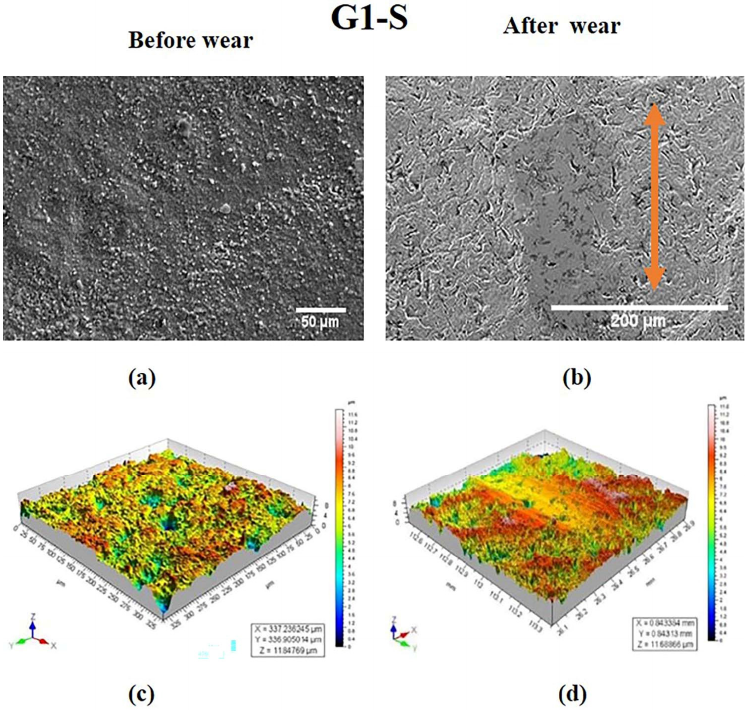
Figure 2. SEM images of specimen in G1 group at magnifications of ( a ) 50 μ m and ( b ) 200 μ m. 3 ‐ D surface morphology profile ( c ) before wear ( d ) after wear. Wear track is indicated by arrow. For the specimen in the G2 group, the SEM and 3 ‐ D roughness contour (Figure 3a,c) revealed polishing traces with deep grooves and pits. The 3 ‐ D surface characteristic im ‐ age in Figure 3c revealed high peaks and valleys with micro irregularities all over the surface induced by the polishing process. After wear in the G2 group, no noticeable wear track was observed in the 3 ‐ D topography image (Figure 3d) since the surface was cov ‐ ered with polishing traces. Though the SEM image in Figure 3b did not reveal wear track, surface undulations could be observed. From the SEM image (Figure 4a) of the specimen in the G3 group, polishing traces with shallow depth were observed. This is further evident from the 3 ‐ D image in Figure 4c. The process of sandblasting filled the grooves and pits. Additionally, the large debris was closed by the sandblasting particles leaving very small polishing traces and delam ‐ ination. The 3 ‐ D topography (Figure 4d) after wear in the G3 group specimen revealed a wear track.